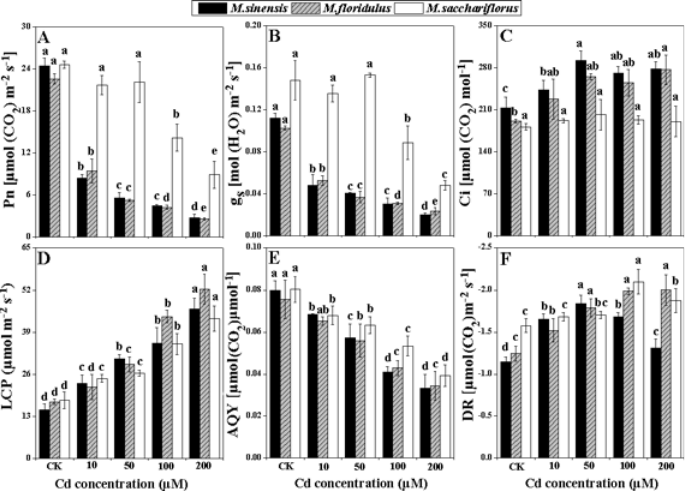
Fig 3. Changes in photosynthetic parameters. (A) Net photosynthetic rate (Pn), (B) stomata conductance (g s ), (C) intercellular CO 2 concentration (Ci), (D) light compensation point (LCP), (E) apparent quantum yield (AQY), (F) dark respiratory rate (DR). Data are mean ± SD (n = 3). Different letters indicate a significant difference at P <